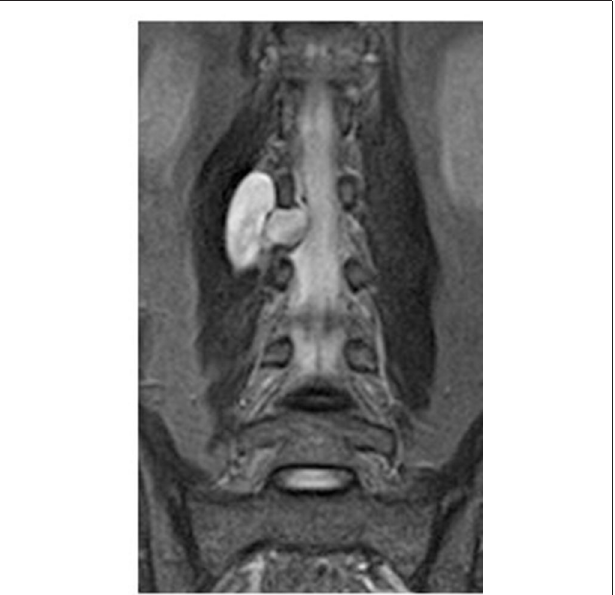
FIGURE 2 | Preoperative contrast-enhanced MRI of the lumbar spine.